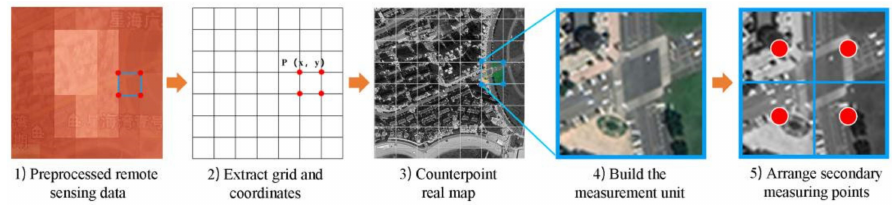
Figure 4. The relationship between remote sensing data and measured data. Division of measurement windows, three observation windows (upper, horizontal, and lower windows) divide the ground space into three directions (Figure 5) at each sec- ondary measurement point. The upper window mainly observes the light environment of the night sky layer of the city. The horizontal window mainly observes the light environ- ment of the human eye in the horizontal direction. The lower window mainly observes the light environment on the ground.